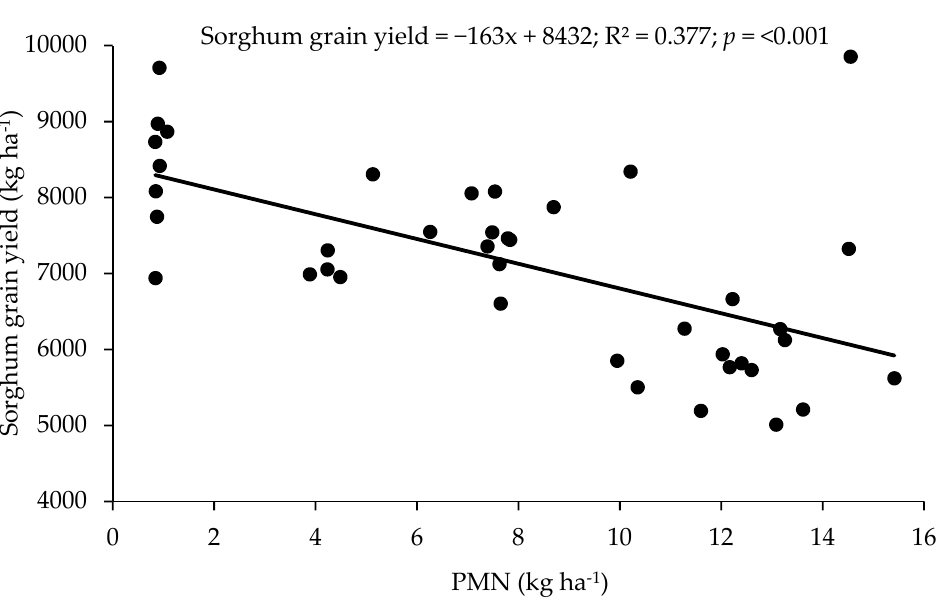
Figure 1. Simple linear regression between inorganic nitrogen (N) and potentially mineralizable N (PMN) and carbon (PMC) ( n = 40) under various cover crop treatments in 2016–2020.